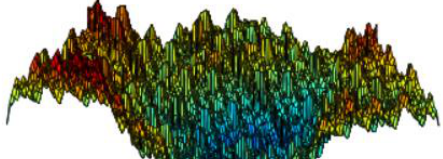
Figure 1. A fractal interpolation curve.